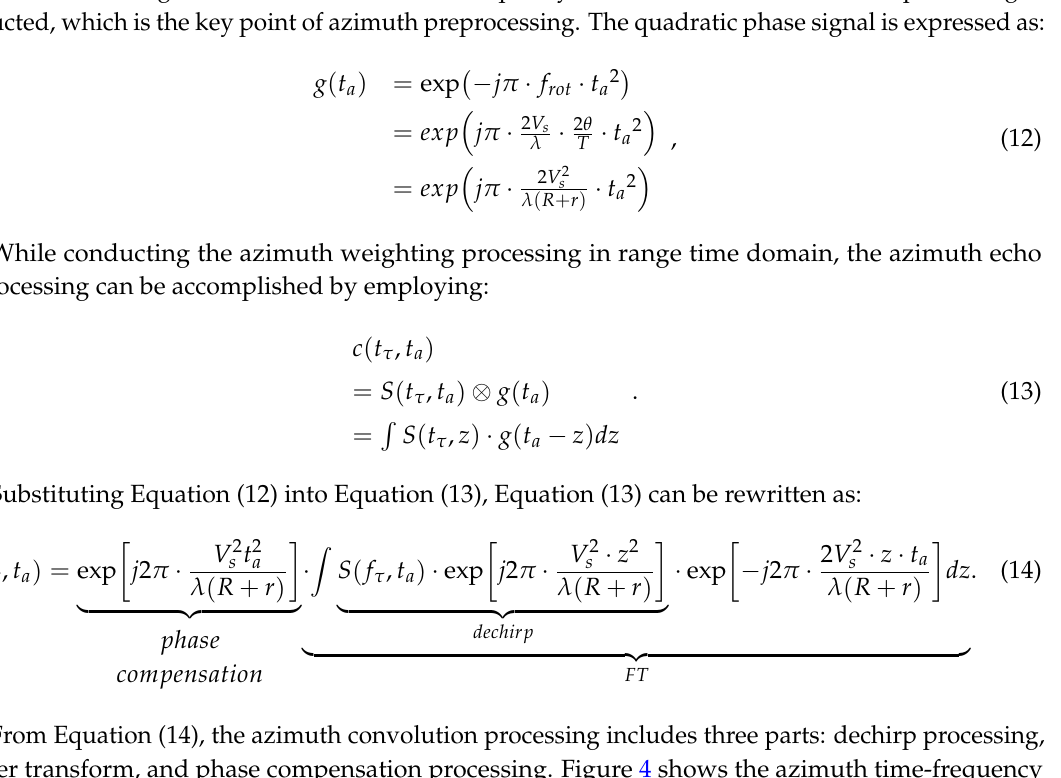
T represents synthetic aperture time and s